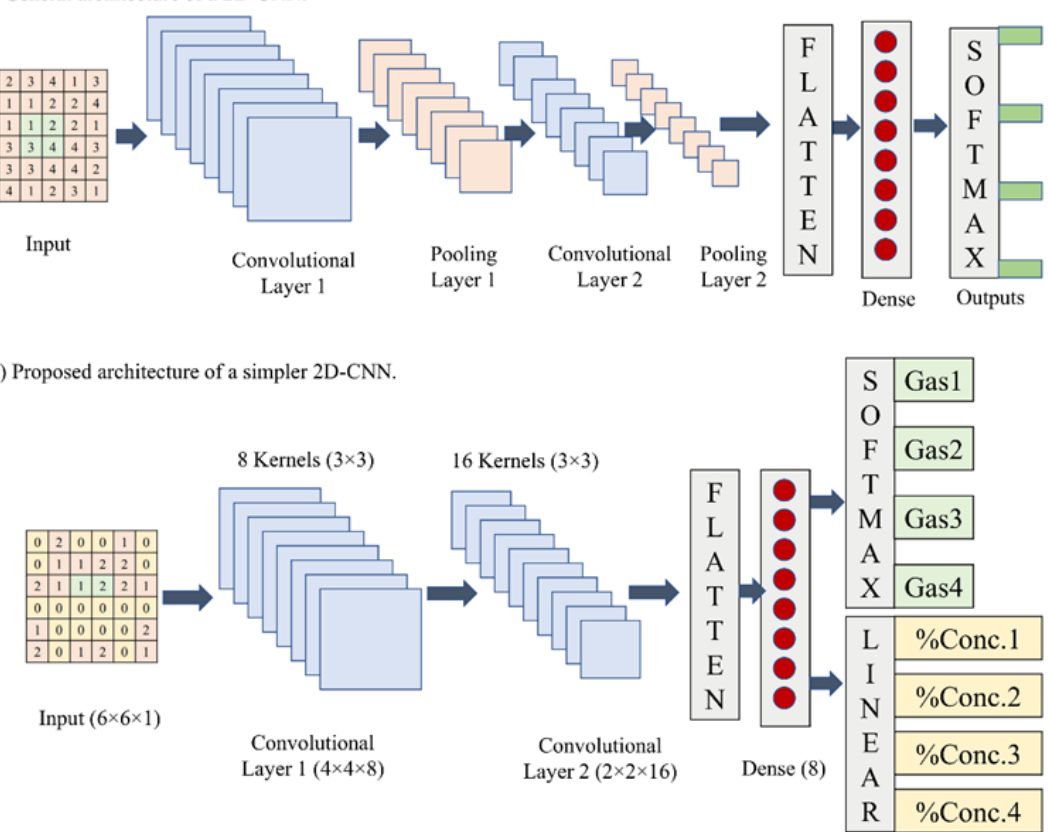
Figure 3. The general architecture of CNN consisting convolutional and pooling layers ( a ); Customization of the general architecture of a 2D-CNN for gas sensor node optimization suitable for resource-constrained 6G-IoT scenarios ( b ).